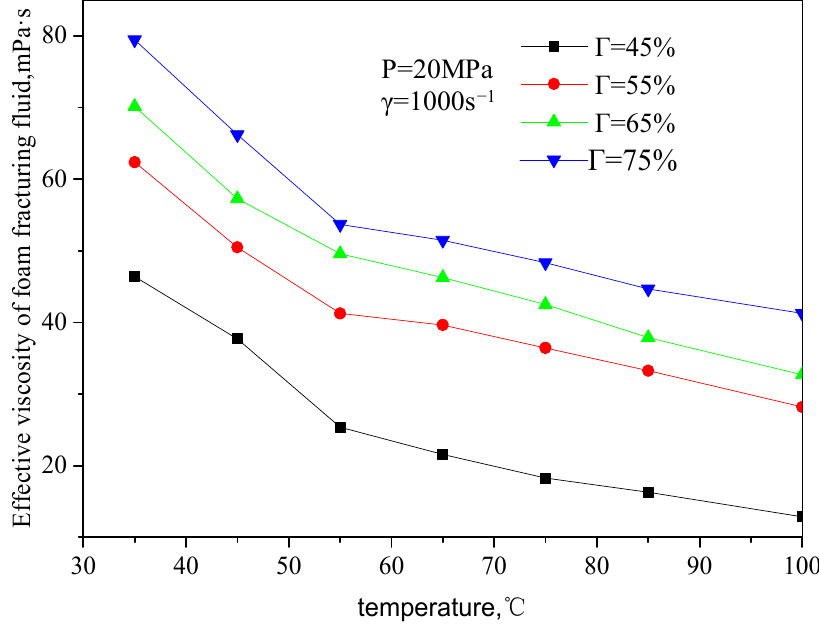
Figure 8. Variation curve of effective viscosity with temperature (foamed, the shear rate is 1000 s − 1 ).